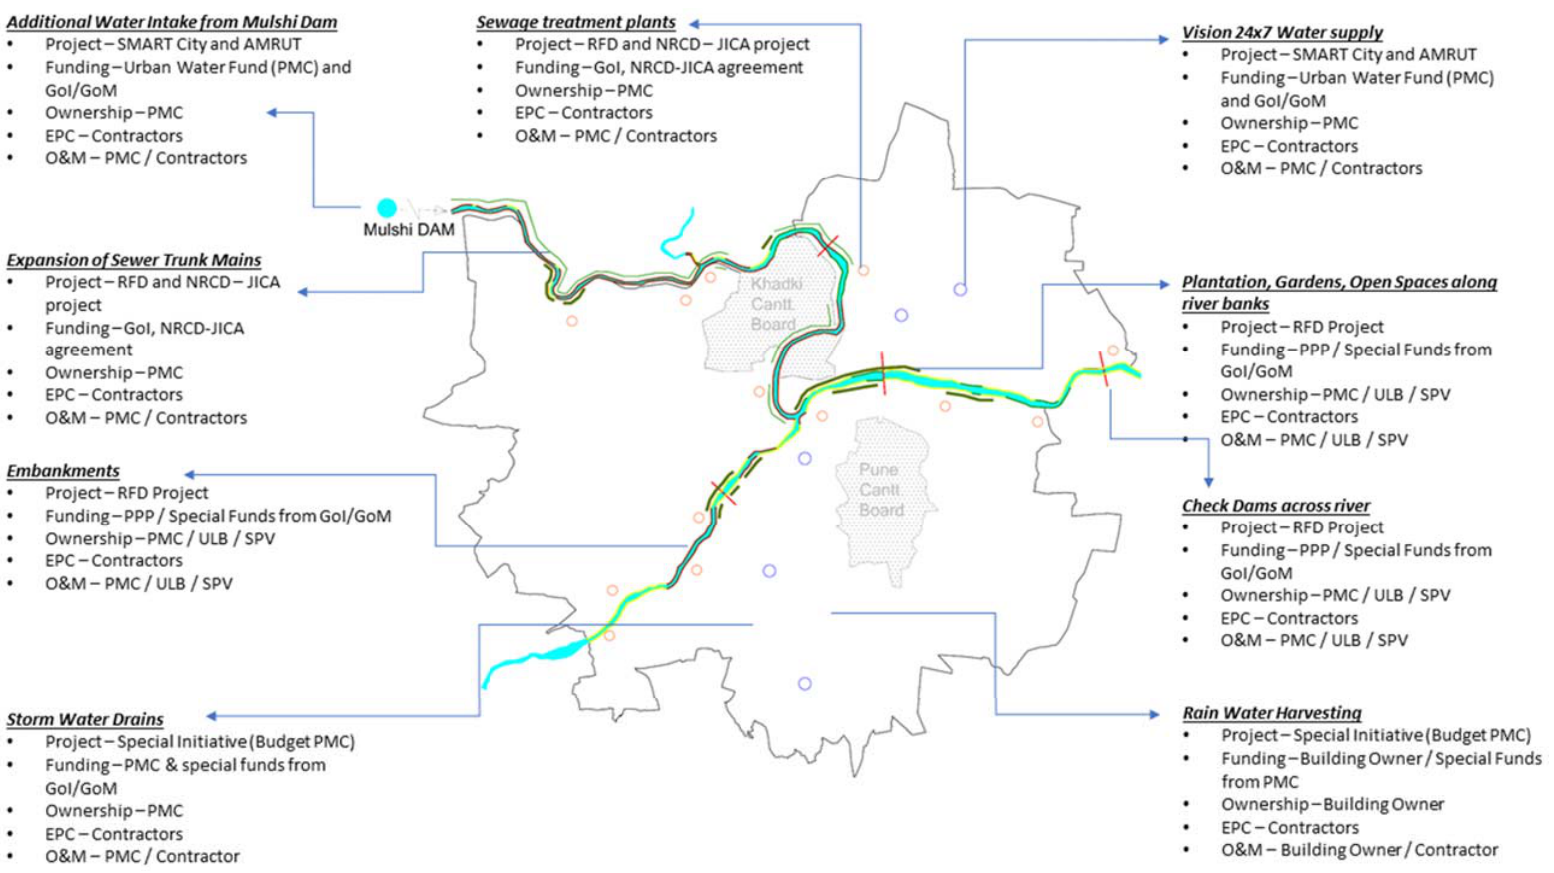
Figure 5 . Funding and ownership details of adaptation responses. Figure 5. Funding and ownership details of adaptation